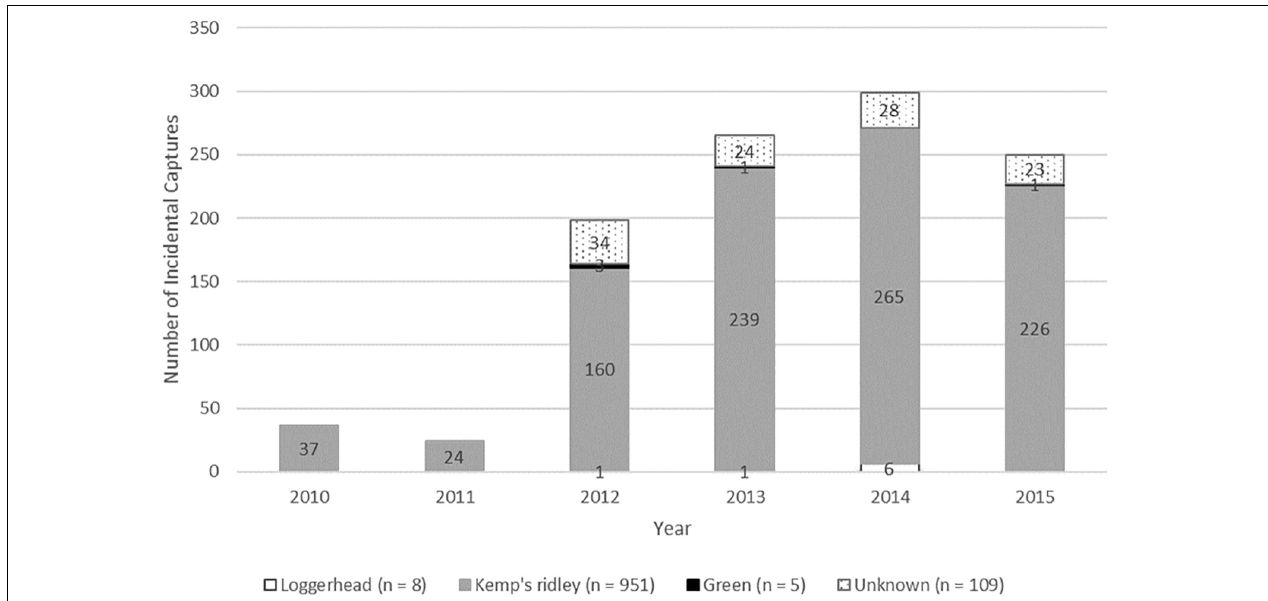
FIGURE 1 | Reported sea turtle species ( n = 1,073) caught on hook and line by recreational anglers fishing on Mississippi piers from 2010 to 2015. Source: (NOAA Sea Turtle Stranding and Salvage Network [STSSN], https://grunt.sefsc.noaa.gov/stssnrep/).